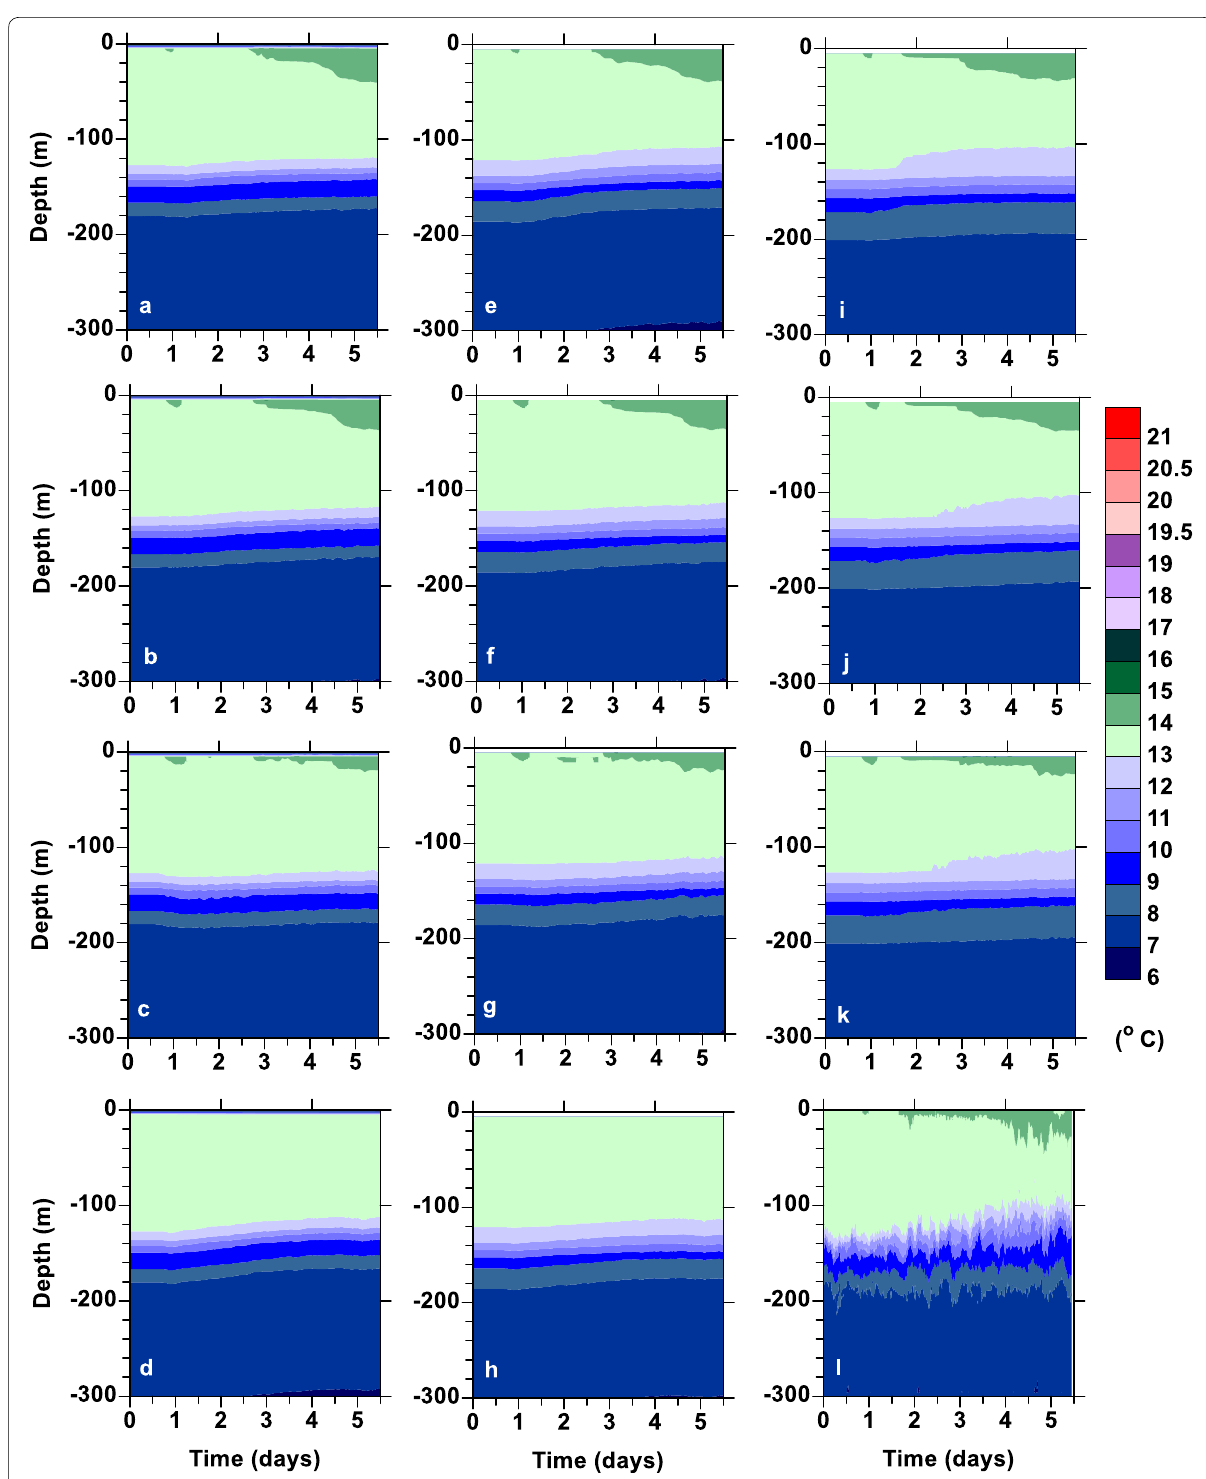
Fig. 2 Potential temperature with depth during the FLX91 simulations ( a – k ) and the observations l. The simulations were done with ( a – d ) 100 levels, ( e – h ) 50 levels, and ( i – k ) 25 levels. The results from Nakanishi – Niino are given in ( a , e , i ), those from Mellor – Yamada 2.5 in ( b , f , j ), GLS in ( c , g , k ) and Large – McWilliams – Doney in ( d , h ). No results are shown for Large – McWilliams – Doney for 25 levels as they were essentially the same as those for 50